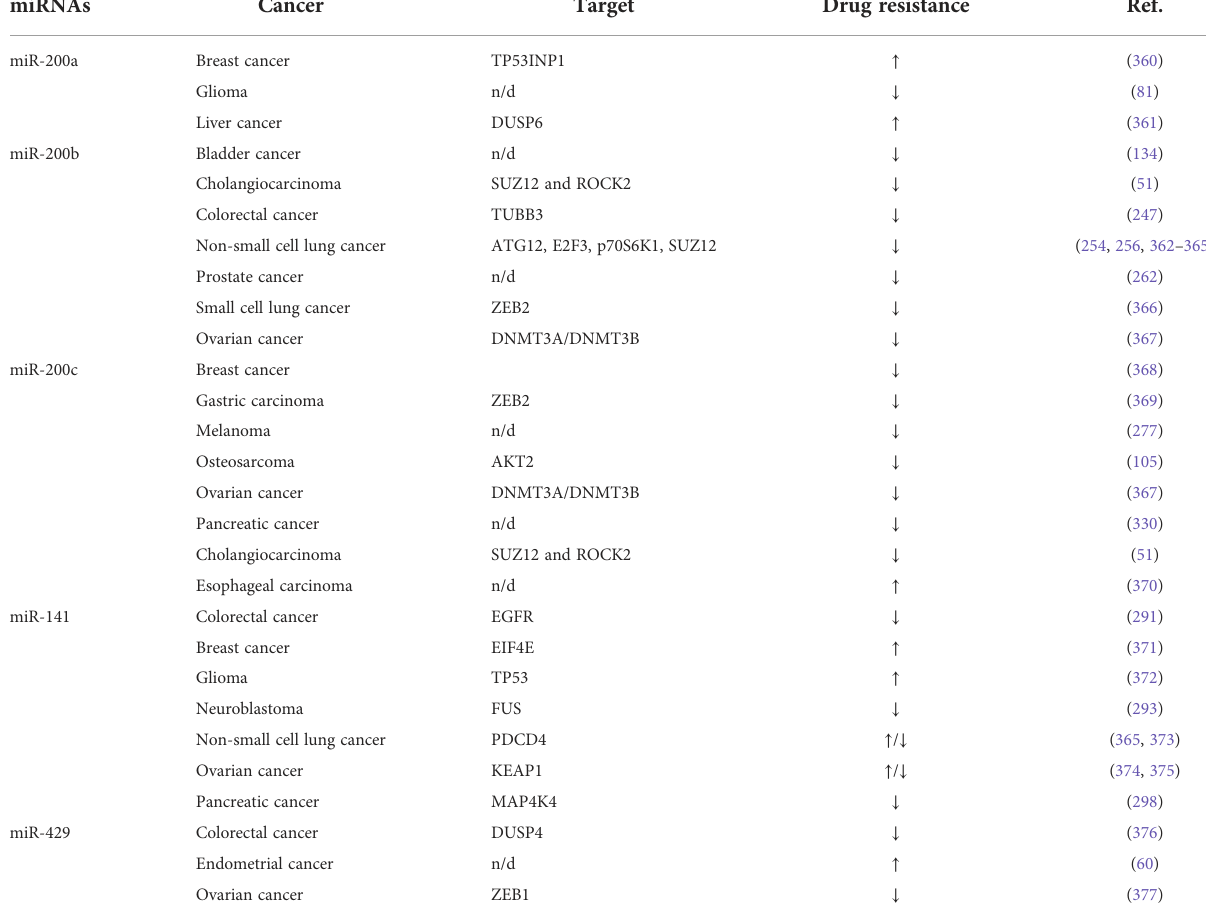
TABLE 7 Regulation of drug resistance by miR-200 family members.